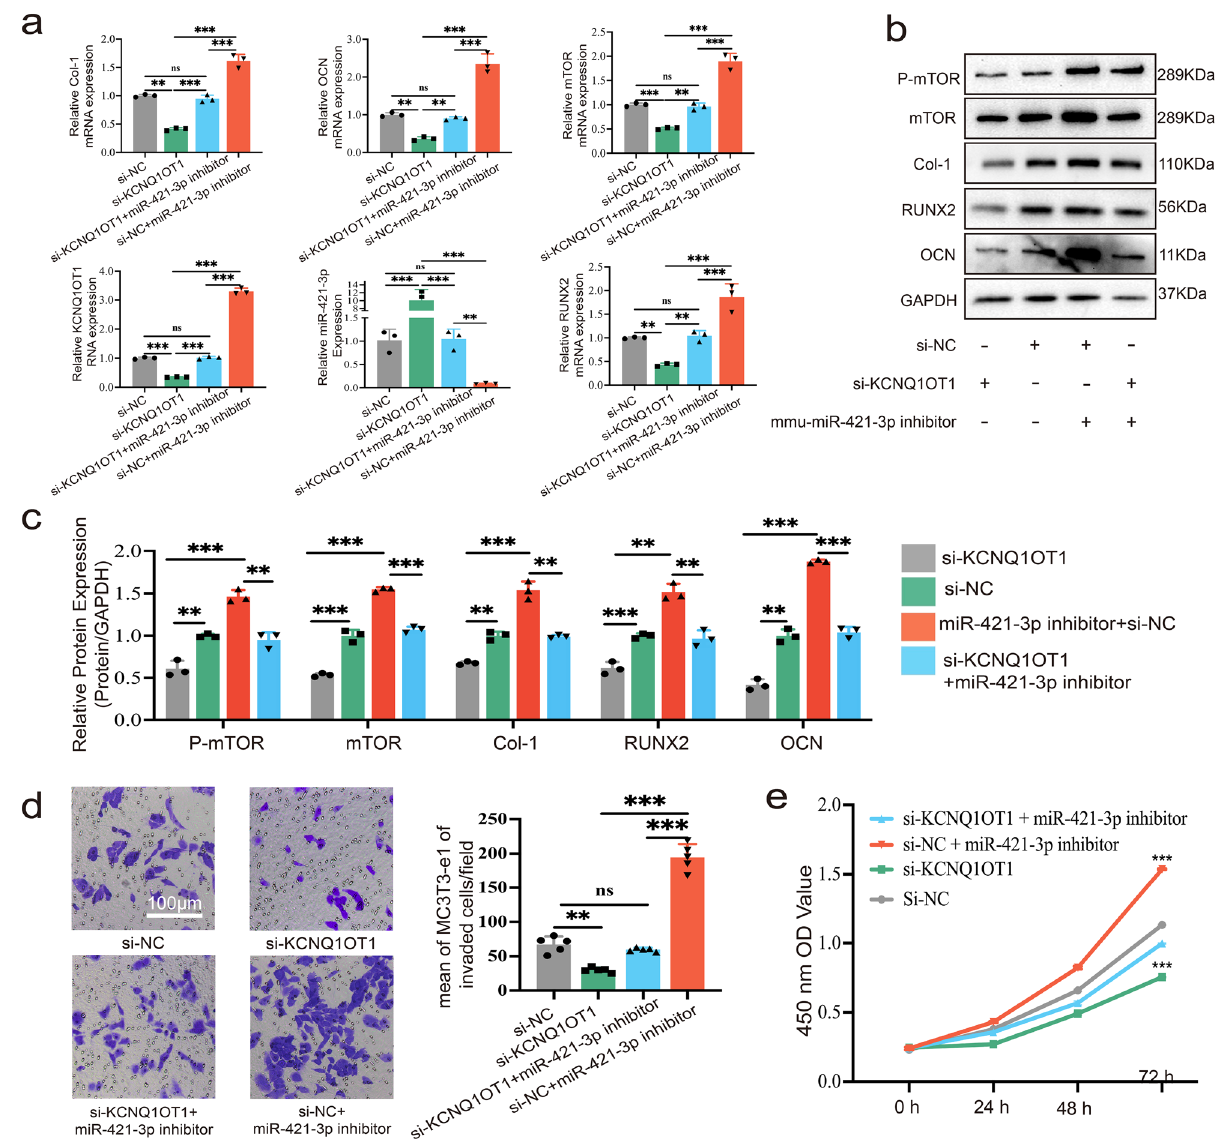
Figure 6. KCNQ1OT1 enhances cell proliferation, migration, and osteogenic differentiation by up-regulating mTOR via sponging miR-421-3p. MC3T3-E1 cells were transfected with si-KCNQ1OT1, si-NC, si-KCNQ1OT1 + miR-421-3p inhibitor or si-NC + miR-421-3p inhibitor respectively. ( a ) qRT-PCR showed the relative RNA expression of KCNQ1OT1, miR-421-3p, mTOR, Col-1, RUNX2 and OCN of MC3T3-E1 cells. ( b , c ) Protein expression levels of pmTOR, mTOR, Col-1, RUNX2 and OCN of MC3T3-E1 cells after transfection and culture in osteogenic differentiation induction medium for seven days. Uncropped Western blot images are shown in Supplementary Fig. 8. ( d ) Transwell migration assay showed the migration ability of MC3T3-E1 cells among different transfection group. ( e ) CCK-8 assay showed the capacity of MC3T3-E1 cells to proliferate in various transfection groups. ns: no significant, **P < 0.01, ***P <